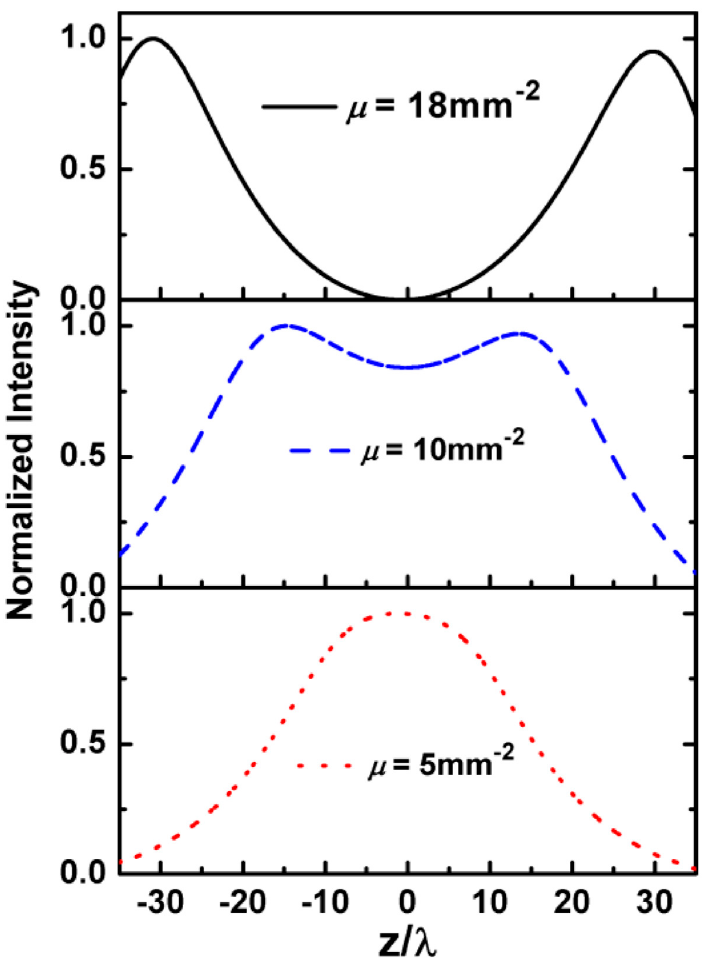
Figure 6. Influence of cross-phase modulation on the intensity distribution along the optical axis. Parameters for calculation are chosen as λ = 633 nm, α = 3, NA = 0.9, f = 3.4 cm, and E 0 =